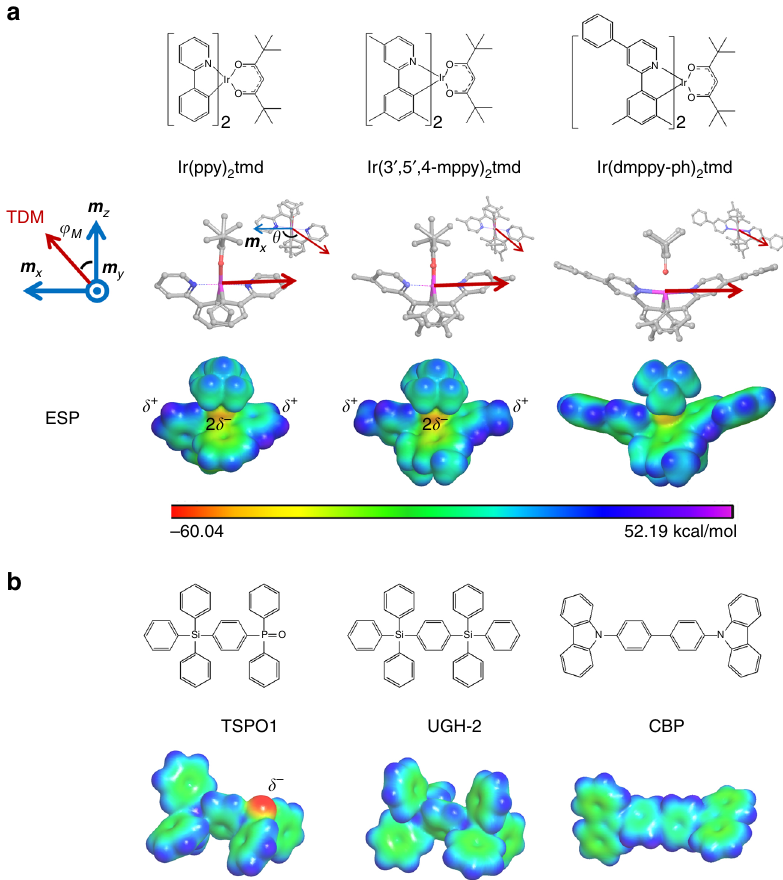
Fig. 2 Iridium complexes and host materials. a Chemical structures, transition dipole moment vectors, and electrostatic potentials of Ir(ppy) 2 tmd, Ir(3 ′ ,5 ′ ,4- mppy) 2 tmd, and Ir(dmppy-ph) 2 tmd phosphors. There are linear quadrupoles in the ground state of Ir(ppy) 2 tmd and Ir(3 ′ ,5 ′ ,4-mppy) 2 tmd with quadrupole moments along the principal axes of Q xx,yy,zz = [25.2, − 13.0, − 12.2] and [27.1, − 12.8, − 14.3] Debye · Å 2 , respectively. b Chemical structures and electrostatic potentials of UGH-2, CBP, and TSPO1 host molecules. The electrostatic potentials are projected on the isosurface of electron density of 0.005 electrons/ bohr 3 . The color legend is identical to that for Ir complexes. Optimization of the molecular structures was demonstrated using B3LYP method and LACVP** basis set for the phosphors and 6 – 31 g(d)** for the host materials, respectively. SOC-TDDFT of the phosphors were carried out using B3LYP method